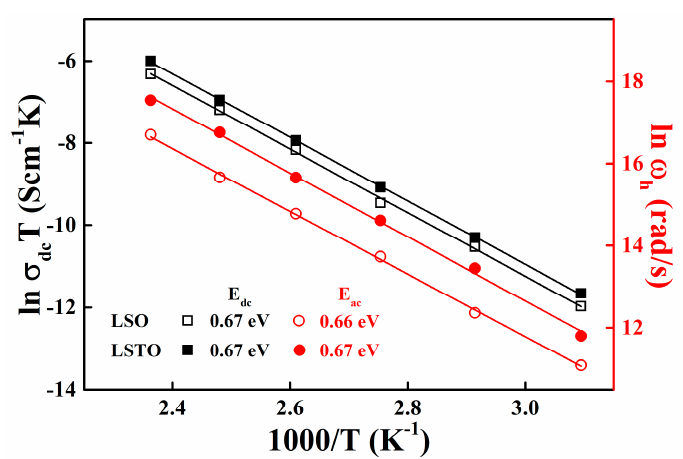
Figure 5. Temperature dependence of the dc conductivity (black: left vertical axis) and the hopping frequency ω h (red: right vertical axis) obtained from the power-law analysis for LSO (opened symbols) and LSTO (closed symbols) glasses. Reciprocal temperature dependence of hopping frequency for two di ff erent compositions of LSO and LSTO glasses obtained from a fit to σ ( ω h ) = 2 σ dc . The red lines indicate that ω h obeys the Arrhenius relation. The solid lines are the least-squares straight-line fits to the data.